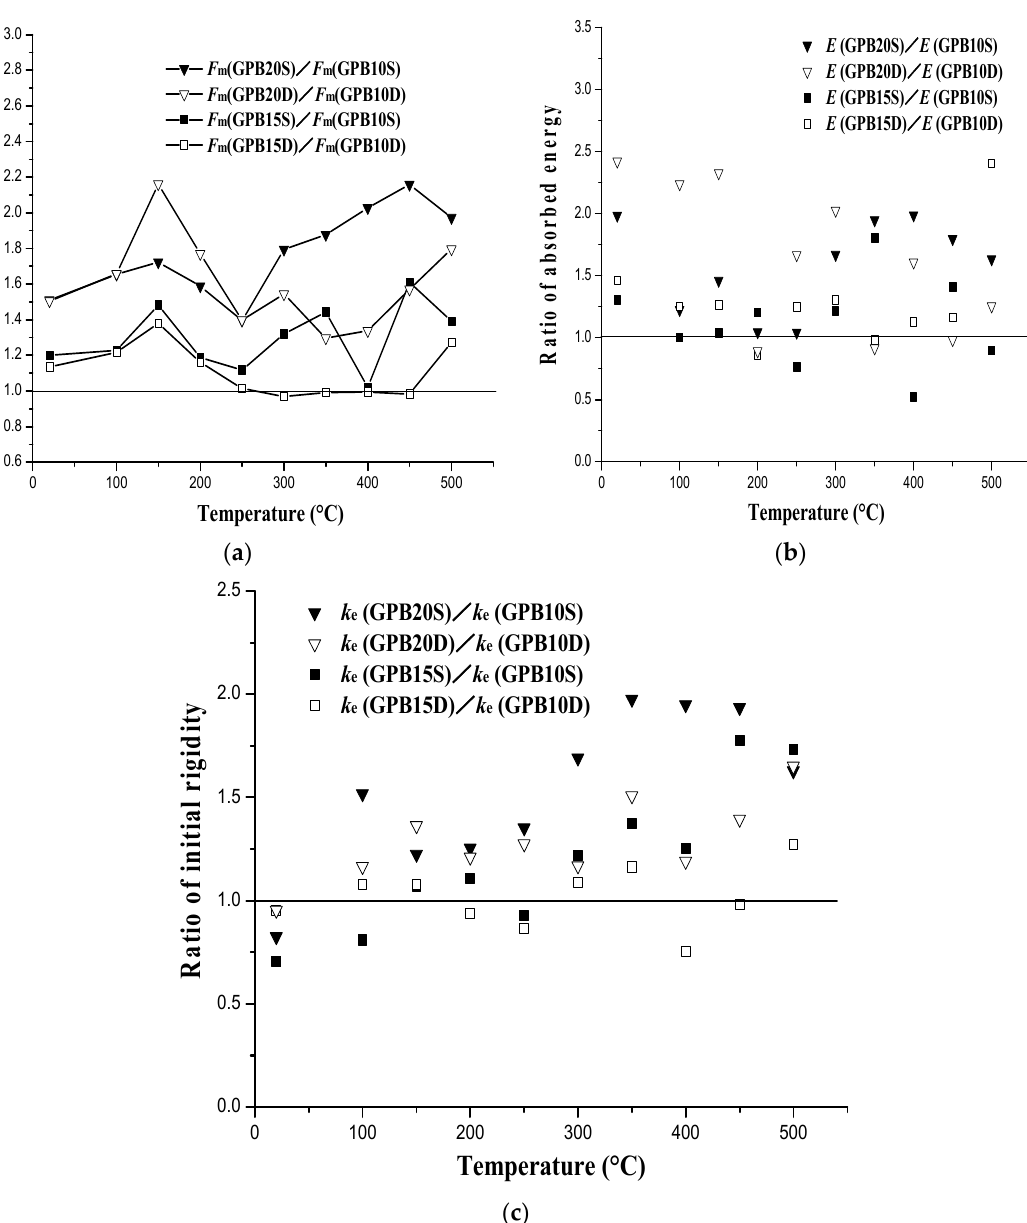
Figure 11. Effect of the loaded edge distance: ( a ) ratio of shear strength; ( b ) ratio of absorbed energy; and ( c ) ratio of initial stiffness.